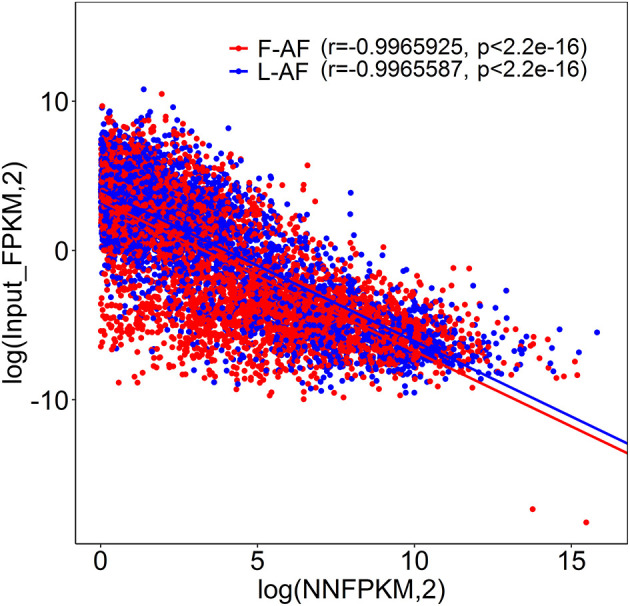
Plot of m6A peak enrichment and mRNA abundance in fat and lean chicken lines. Obvious negative correlation between m6A peak enrichment and modified mRNA abundance was found.